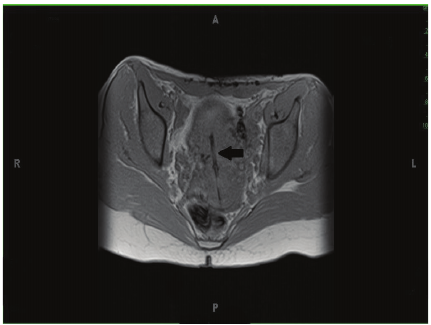
Figure 3: Arrow pointing to right uterine artery approximately 1cm from the site of